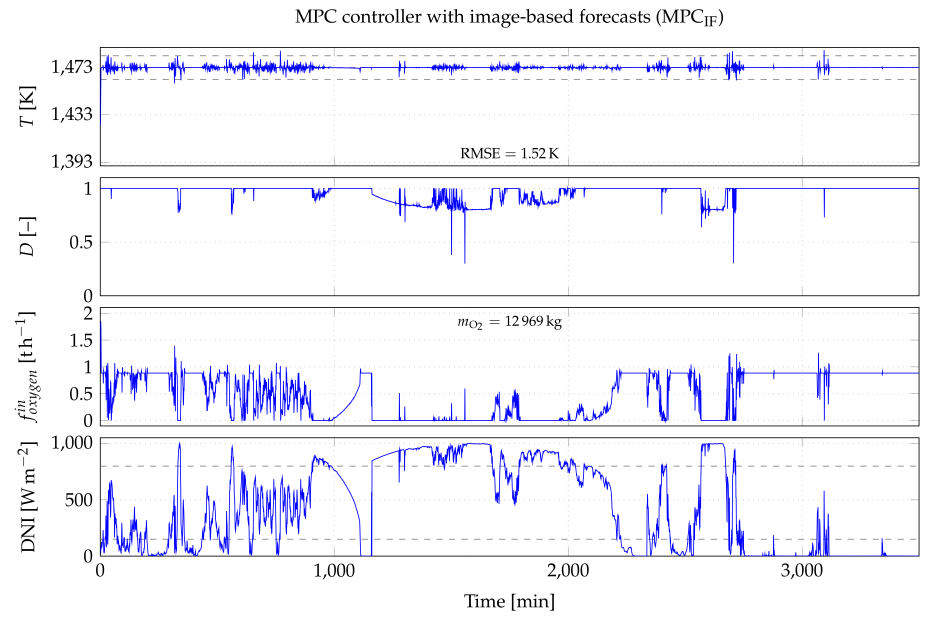
Figure 18. Case study results: MPC controller with image-based DNI forecasts (MPC IF ). The predic- tion horizon of the controller is